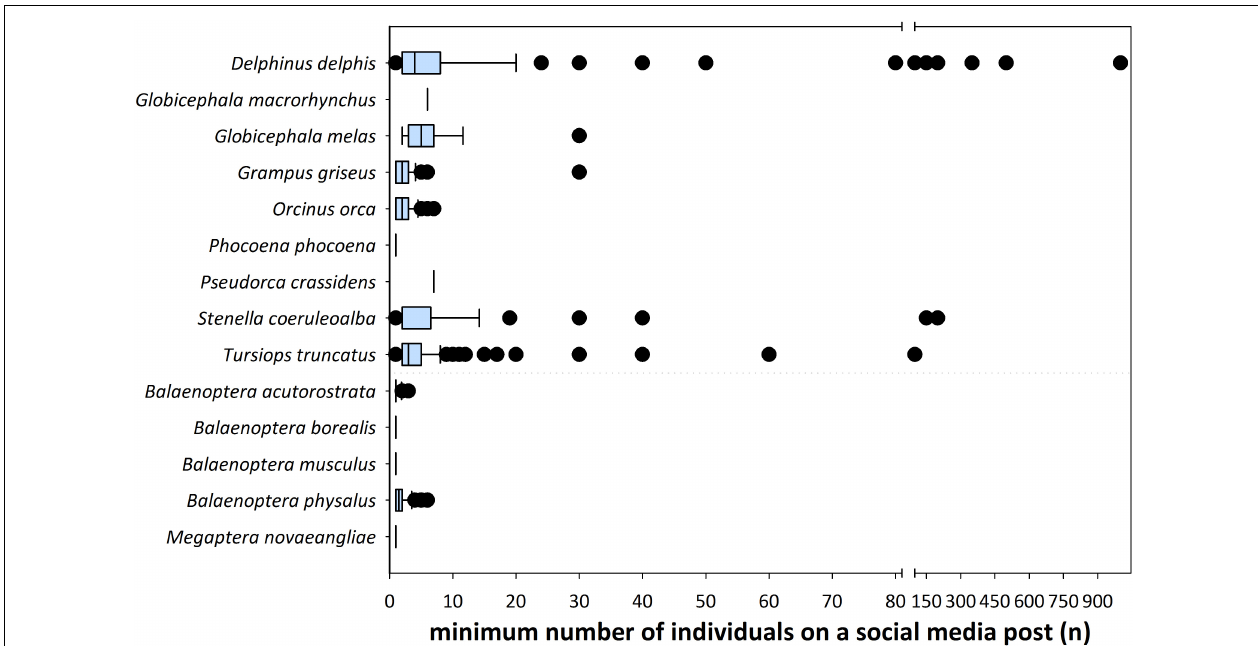
FIGURE 4 | Median, standard error, 25th and 75th percentiles, and outliers of the minimum number of individuals registered in each record and for each cetacean species shown on social media posts published between 2011 and 2020 in the Facebook and Instagram accounts of whale-watching companies from the Algarve (Portugal). The horizontal dotted line separates odontocetes (top) from mysticetes (bottom)